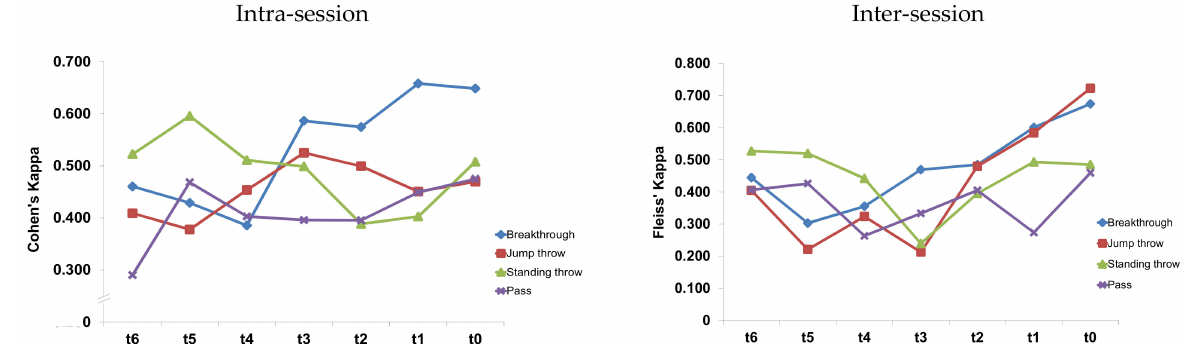
Figure 6. Mean kappa agreement (for both hands) of CoMR for each occlusion and every attack action (intra- and inter-